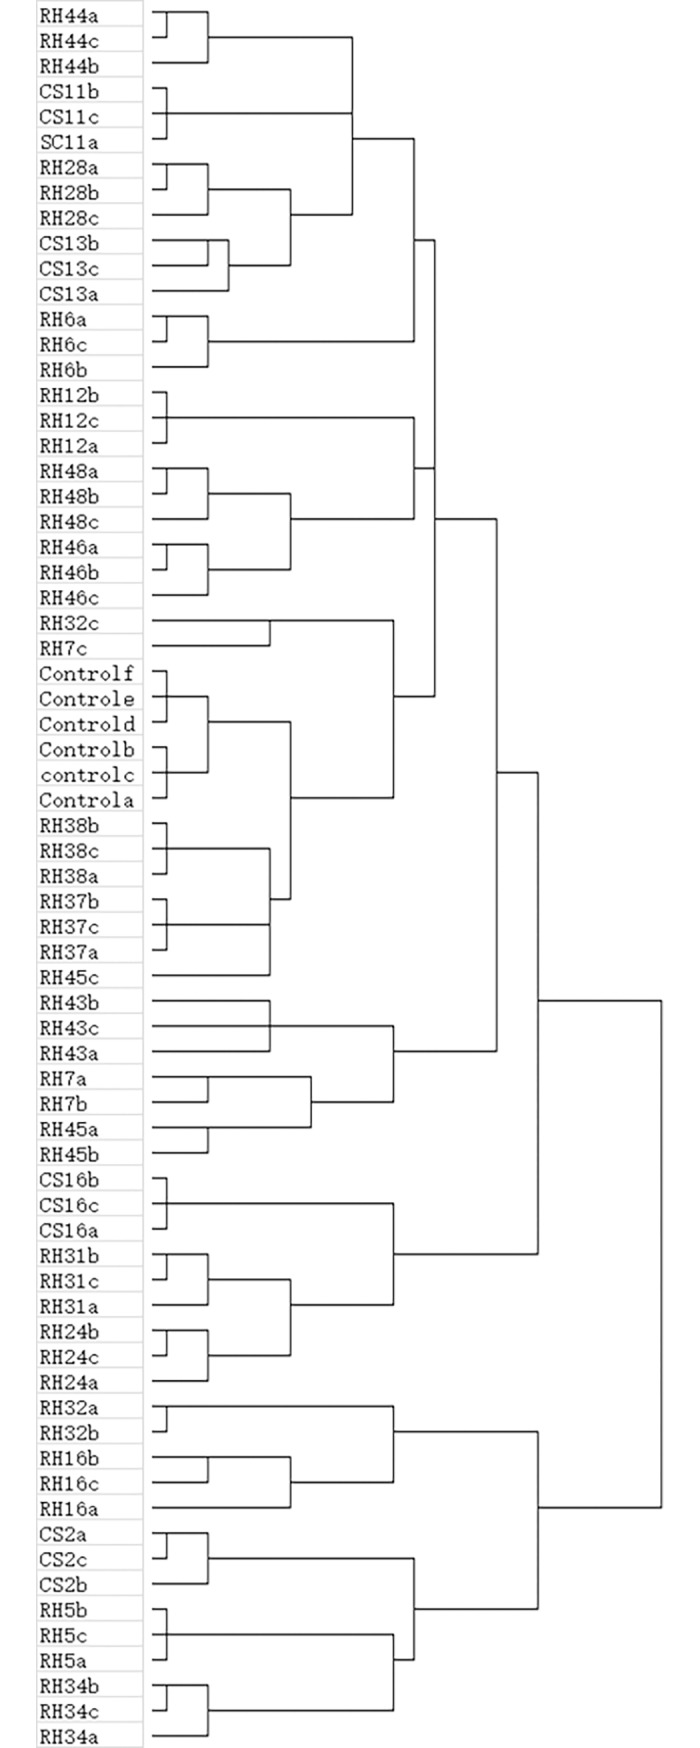
A clustering (Squared Euclidean distance Hierarchical clustering using SPSS 16.0 software) to all replicates of the treatments based on the appearance (1) and absence (0) matrix of detected metabolites.